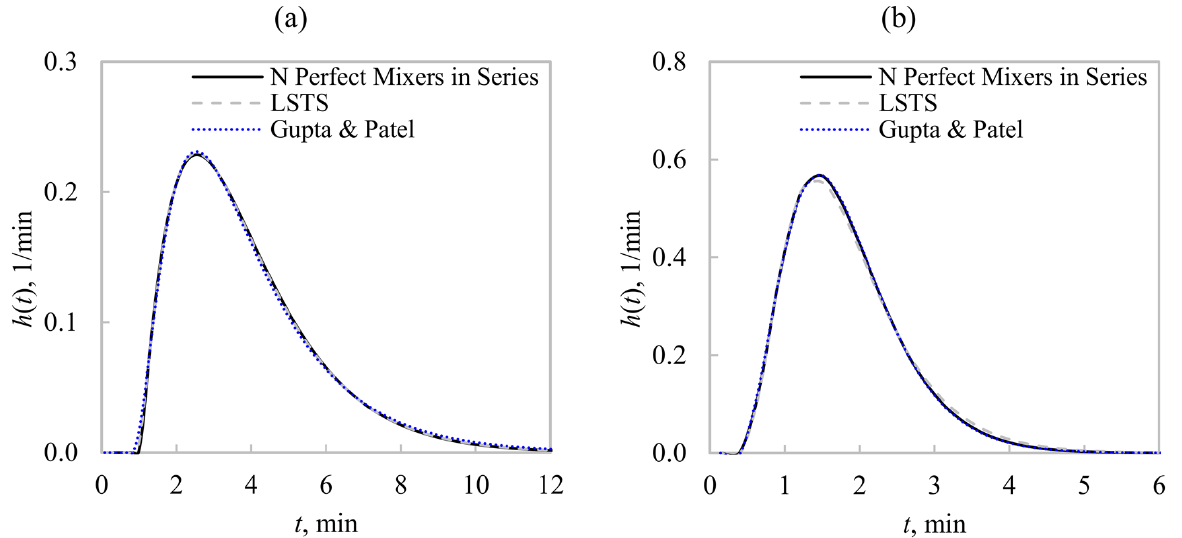
Figure 5. Comparisons of parametric RTD estimates in ball mills: ( a ) Ball Mill 3, Measurement 3, N = 2.1, ( b ) Ball Mill 2, Measurement 2, N = 3.9.